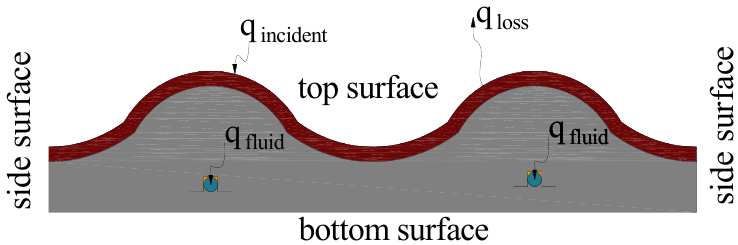
Figure 6. Boundary conditions of the solid